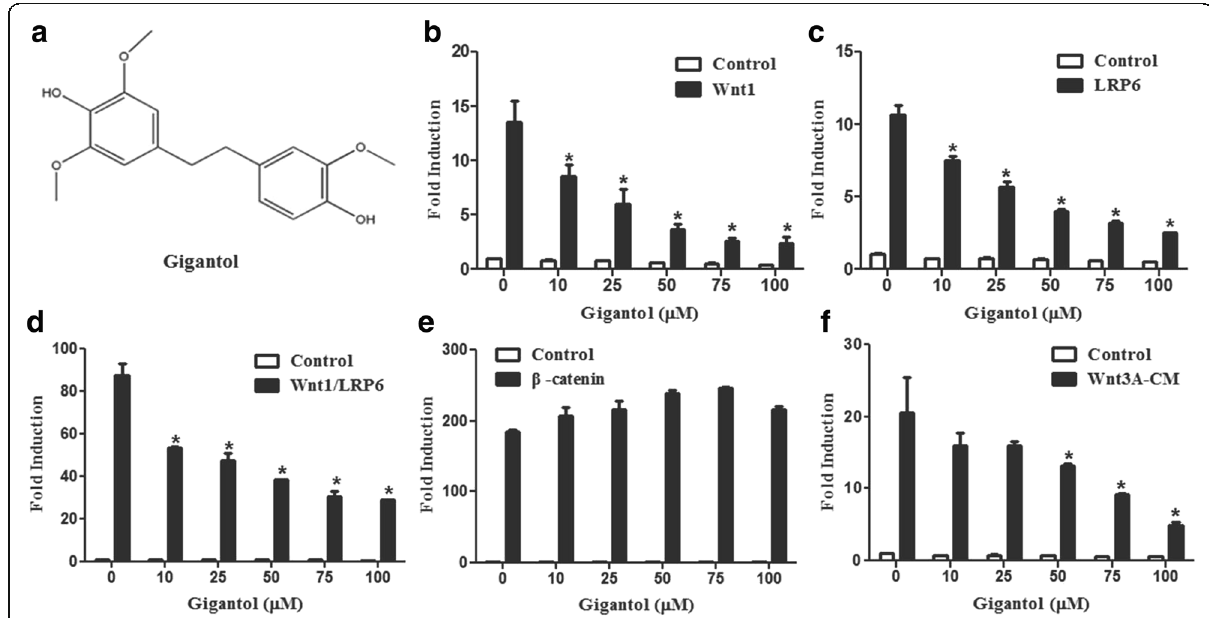
Fig. 1 Gigantol suppresses the activity of the Wnt signaling pathway. a Structure of gigantol. b - e HEK293T cells were transfected with SuperTopFlash reporter gene together with control vector or expression plasmids encoding Wnt1 ( b ), LRP6 ( c ), Wnt1 and LRP6 ( d ), and β -catenin ( e ). After transfection for 24 h, the transfected cells were treated with DMSO or the indicated concentrations of gigantol for 24 h ( f ). The SuperTopFlash reporter gene was transfected into HEK293T cells. At 24 h after transfection, cells were incubated with the control or Wnt3A-CM containing DMSO or the specified concentrations of gigantol for 24 h. The luciferase values were normalized using β -gal activities. Statistical significance between groups is calculated by two-way ANOVA, * P <0.05 compared to cells transfected with Wnt1, LRP6, or Wnt1 and LRP6, or incubated with Wnt3A-CM containing